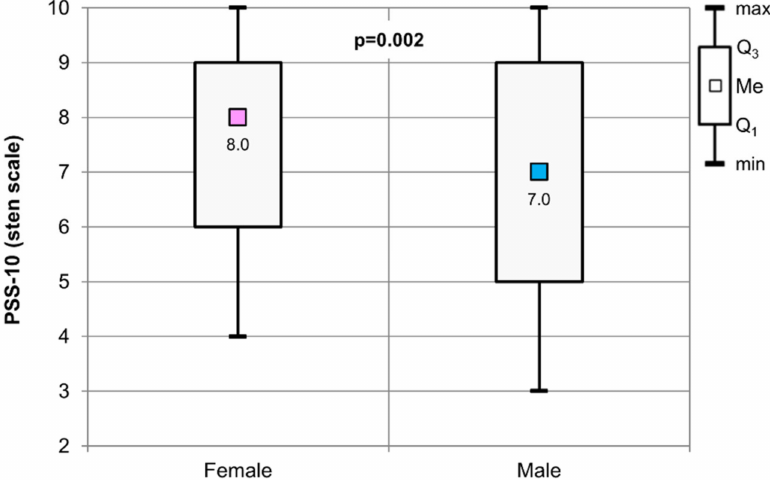
Figure 2. The results of the Mann–Whitney test used to assess the significance of the difference values for the PSS-10 (sten scale) in relation to the gender of the